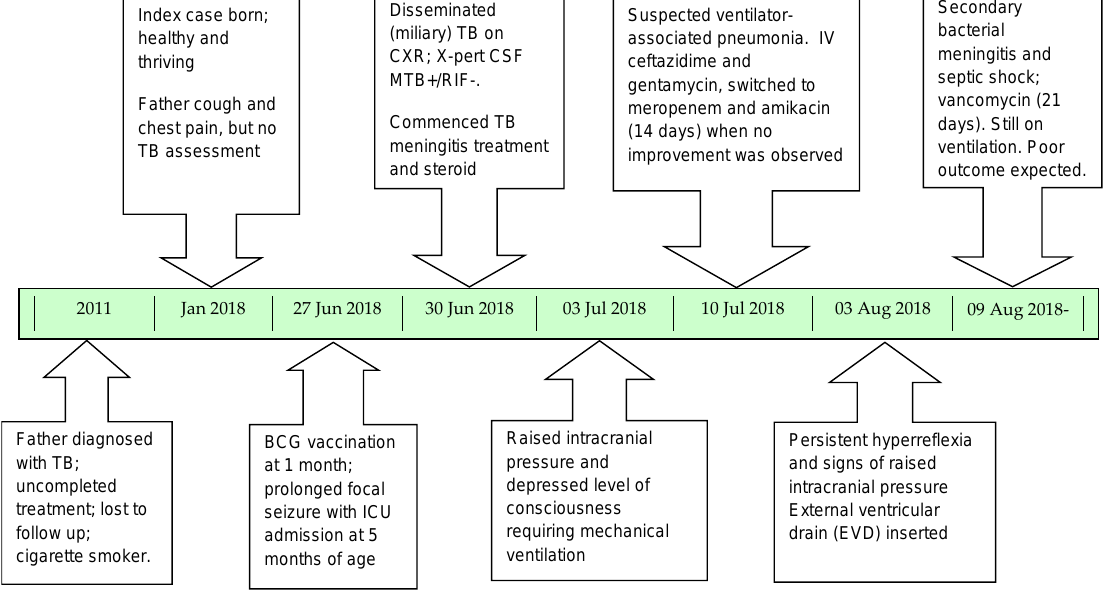
Figure 2. Timeline of relevant events and clinical progress.